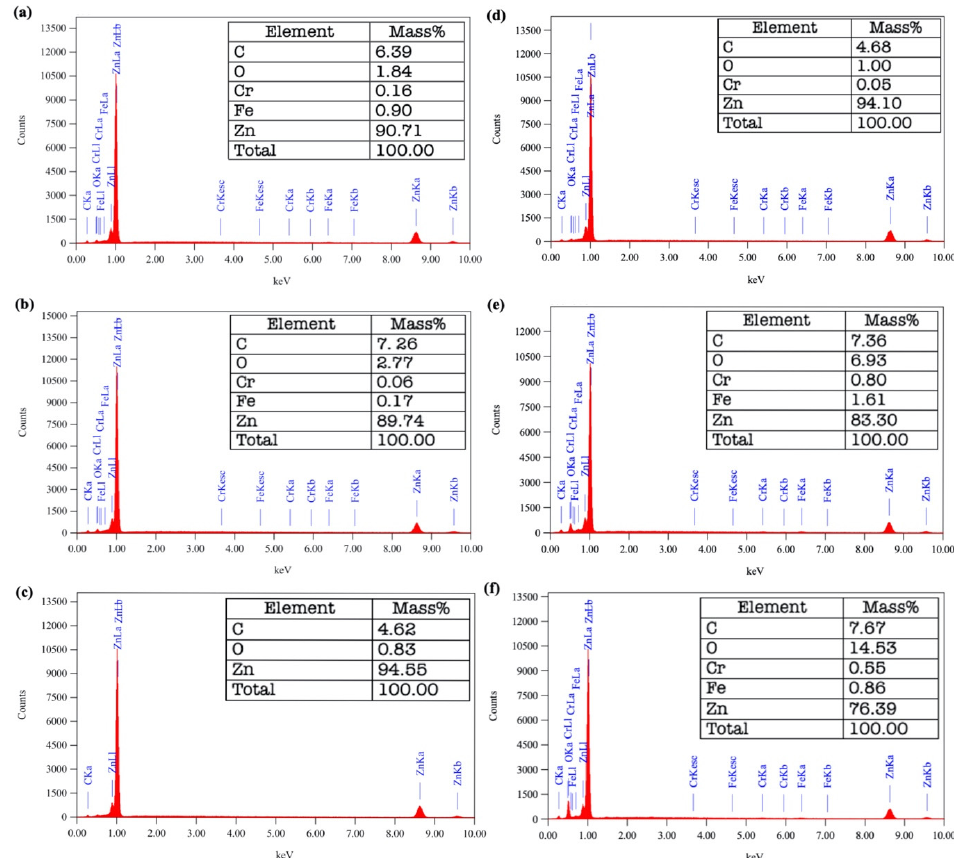
Figure 10. Spot analysis (EDS) at the fracture surface of tensile test results: ( a ) 35 s sample, ( b ) 40 s sample, ( c ) 45 s sample, ( d ) 35 s—100 °C sample, ( e ) 35 s—150 °C sample, and ( f ) 35 s—200 °C sample.